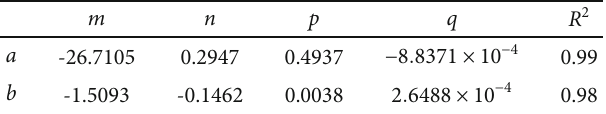
Figure 9: Relationship between parameters a , b , and T , G : Table 5: Initial fi tting parameters for a and b .